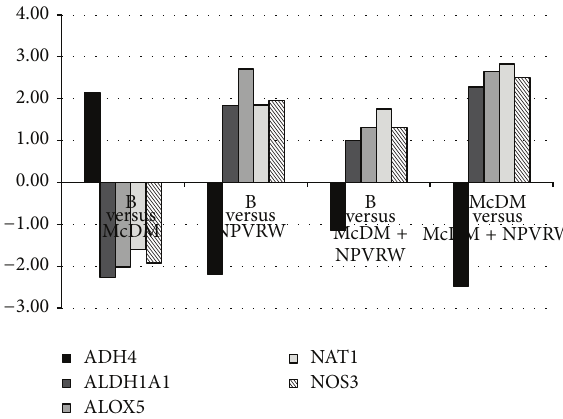
Figure 6: Gene expression in each dietary intervention for Human Drug Metabolism pathway. Different levels of up- and downregu- lation of genes analyzed between McDonald’s meal andMcDonald’s meal with not pruned vineyard red wine. The significant values are expressed as 𝑃 ≤ 0.05 for a level of fold change ± 2.00. Human Drug Metabolism genes: ADH4 , Alcohol Dehydrogenase 4-Class 2 Pi Polypeptide (NM 670); ALDH1A1 , Aldehyde Dehydroge- nase 1 Family Member A1 (NM 689); ALOX5 , Arachidonate 5- Lipoxygenase (NM 698); NAT1 , N-Acetyltransferase 1 (Arylamine N-Acetyltransferase) (NM 662); NOS3 , Nitric Oxide Synthase 3 (Endothelial Cell) (NM